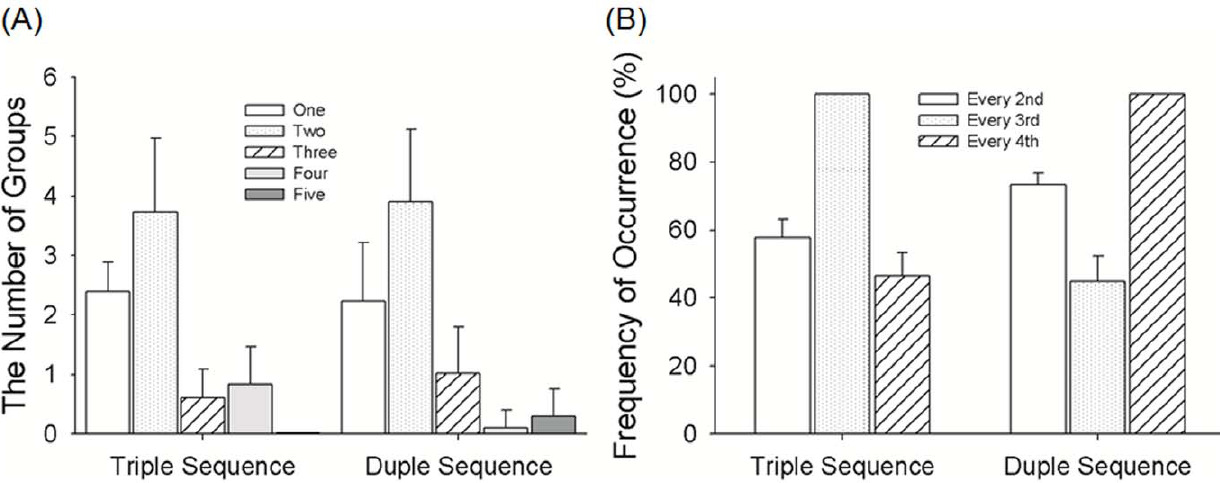
Figure 2. Statistics of the 374 triple and 331 duple sequences. Figure 2A shows the number of successive notes in groups of 1, 2, 3, 4, and 5 occurring in the pool of sequences, indicating the same statistics for Triple and Duple sequences. Figure 2B shows the frequency of a note occurring at every 2nd, 3rd, and 4th unit in the pool of sequences, no difference between Triple and Duple sequences.